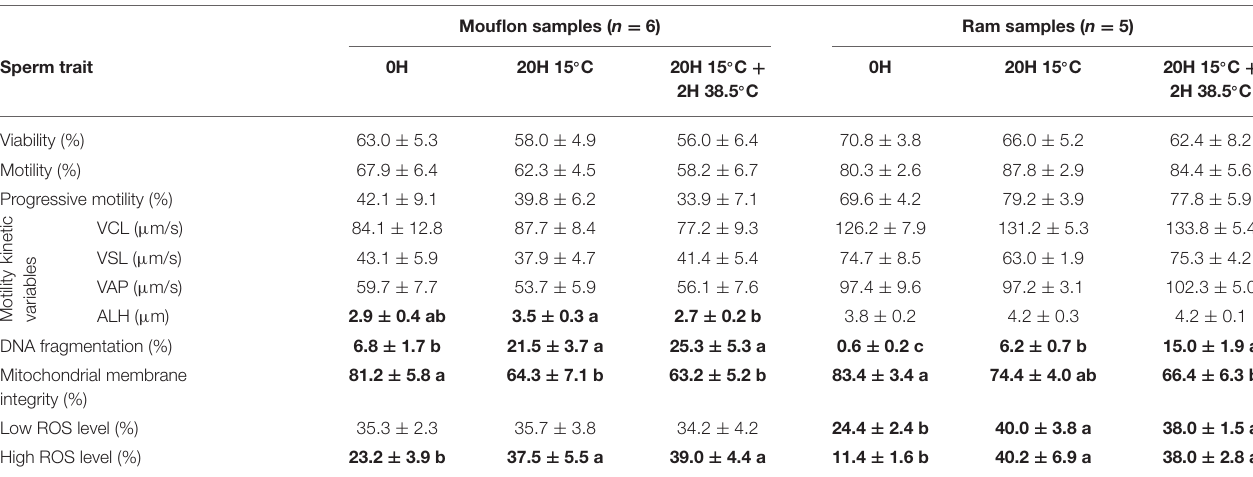
TABLE 2 | Mouflon ( Ovis musimon ) and ram ( Ovis aries ) sperm quality variables (mean ± SE).